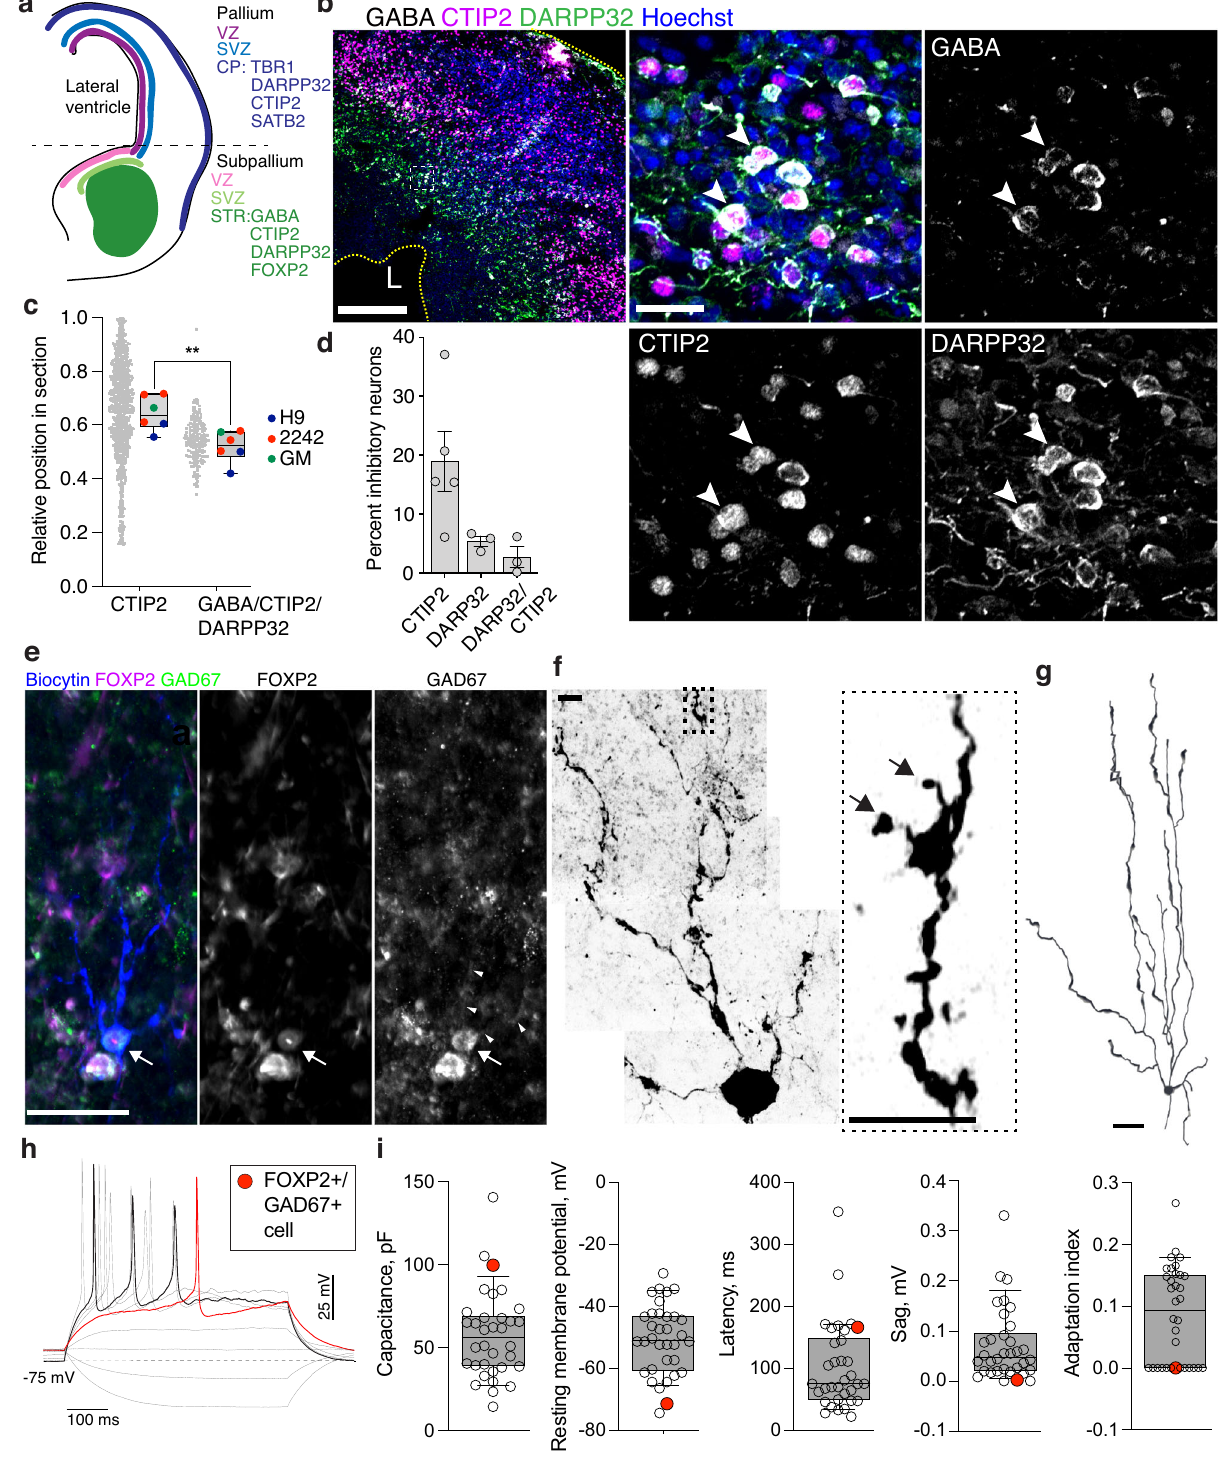
functional neural connections in 6-month-old SNR-derived organoids. The activity was abolished by bath application of a sodium channel antagonist, tetrodotoxin (TTX)(Fig. 9n), supporting the AP-dependent nature of detected electrical activity in organoids. To investigate the presence of oscillatory rhythms, we performed a spectral analysis of the recorded signals, before and after TTX administration (Fig. 9o, p). Oscillations of different frequencies were detected in SNR-derived